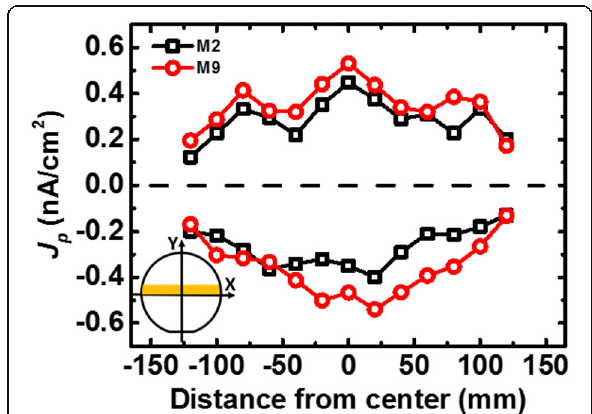
Fig. 8 Comparison of positive and negative charging rate in the center line of a wafer for metal 2 and metal 9 processes. The charging rates peak around the center which means plasma-induced damage is more severe in the center of the